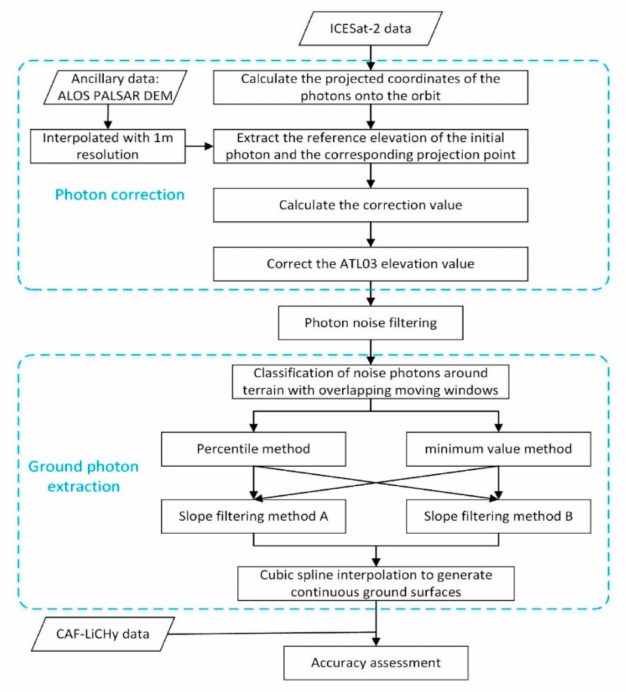
Figure 3. Data processing flowchart of photon-counting lidar.